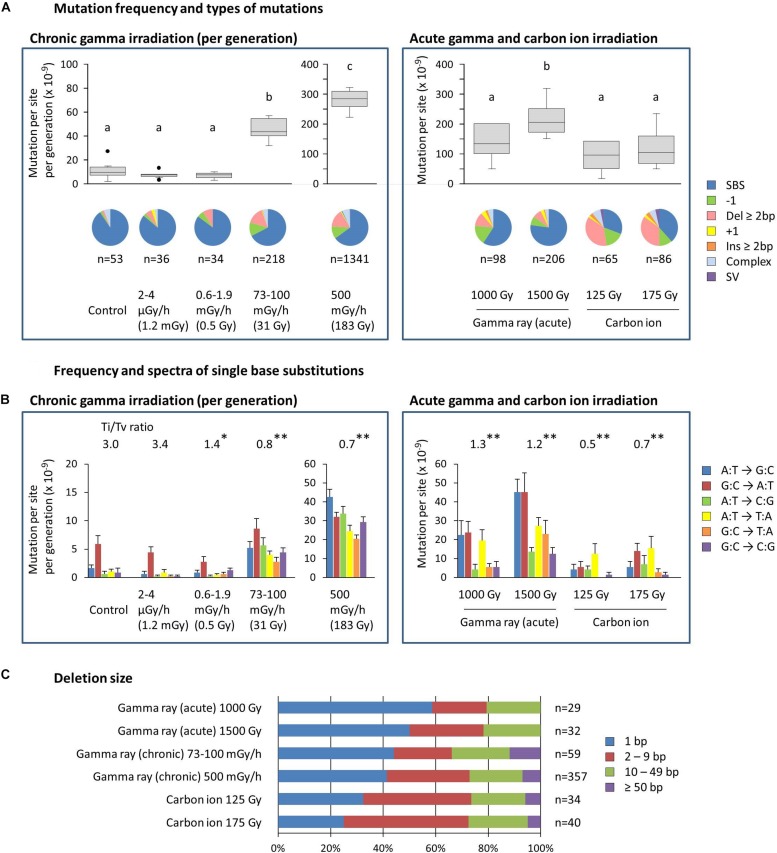
Characterization of the homozygous mutations induced by chronic and acute gamma ray and carbon ion irradiation. (A) Mutation frequency per generation and types of mutations. Mutation frequencies are shown with a box and whisker plot. Different letters indicate significant differences in each of the chronic and acute irradiation (one-way ANOVA with multiple comparison test, p < 0.05). Numbers below the pie graphs indicate the total number of mutation events identified in each experimental group. Doses in parentheses for chronic gamma irradiation represent the mean total dose received per generation. (B) Frequency and spectra of single-base substitutions. Ti/Tv ratios represent the ratios of total transition to transversion events. Asterisks indicate significant differences from the control’s ratio (Chi-squared test, ∗p < 0.05, ∗∗p < 0.01). Complementary substitutions (e.g., G:C to A:T and C:G to T:A) were merged. Doses in parentheses for chronic gamma irradiation represent the mean total dose received per generation. (C) Ratios of deletion sizes. Numbers indicate the total number of deletions identified in each experimental group.